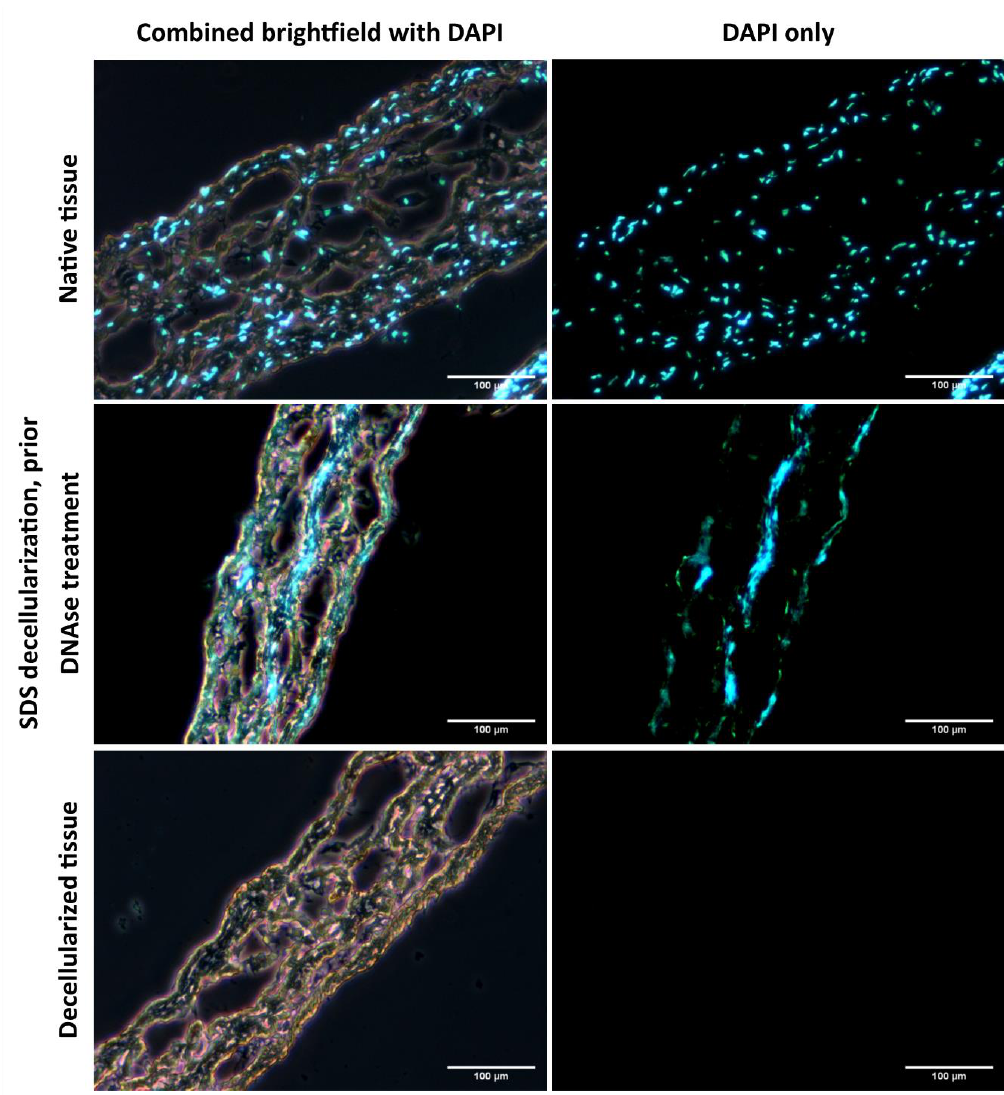
Figure 6. Evaluation of the decellularization process using cryosections 10 µm in thickness stained with DAPI. The brightfield images and the fluorescence images were combined to visualize both the tissue and the remaining nuclei/DNA. From top to bottom: A sample of native tissue with visible cell nuclei. The tissue after SDS cycles, where no cell nuclei are visible, but the residual DNA is spilt over the tissue. A completely decellularized tissue with no remaining visible cells or DNA residues. The Leica DMi 8 microscope, 10x objective, and scale bar 100 m were used.